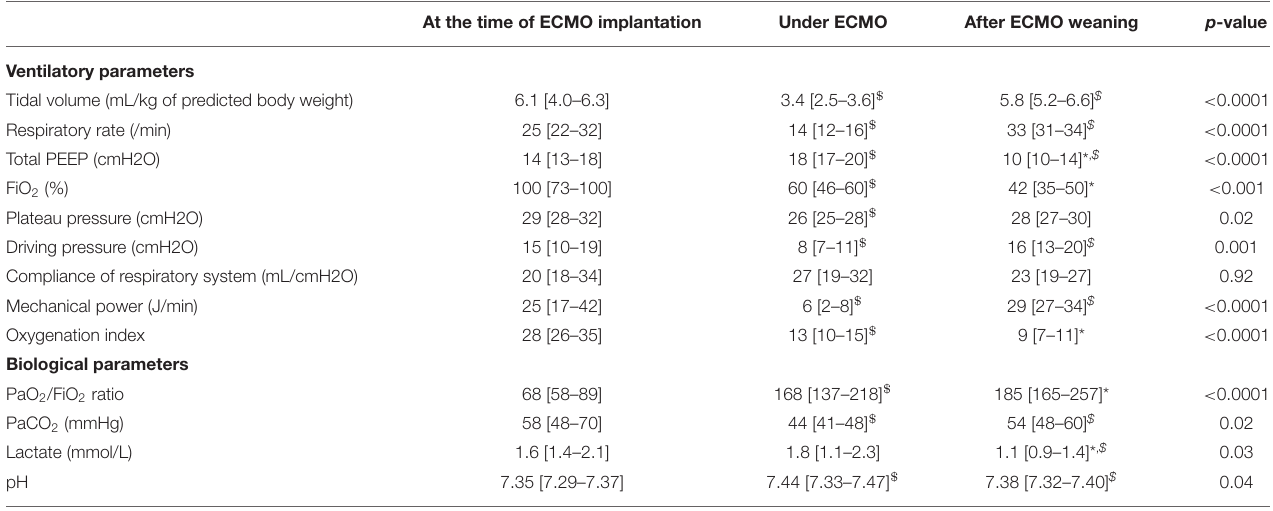
TABLE 2 | Ventilatory and biological parameters at the time of ECMO implantation, under ECMO and after ECMO weaning. At the time of ECMO